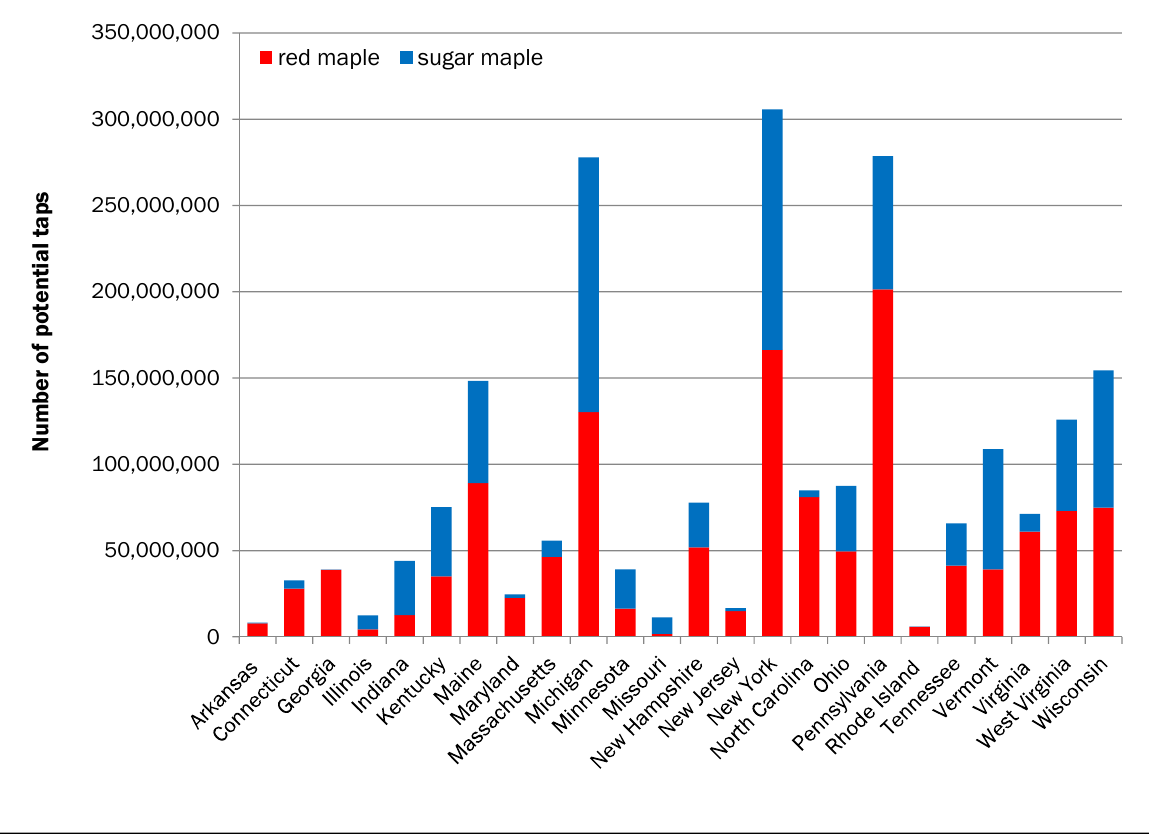
Source: U.S. Department of Agriculture, Forest Service.